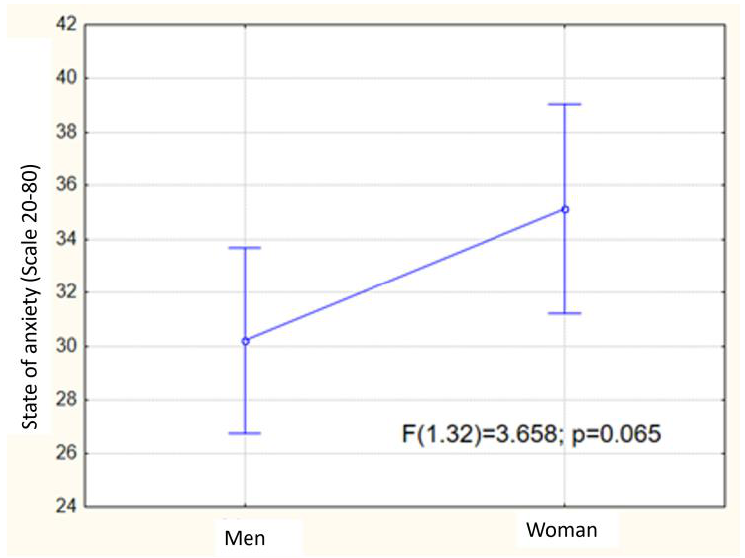
Figure 2. Graphic interpretation of the state of anxiety with regard to sex type (non-significant p > 0.05).